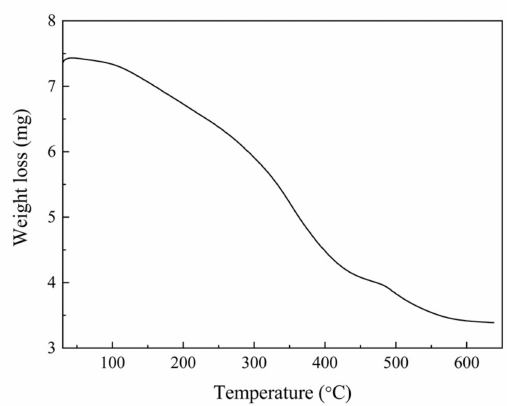
Figure 5. TGA curve of the gel powder of the composite material doped with 5 wt. %